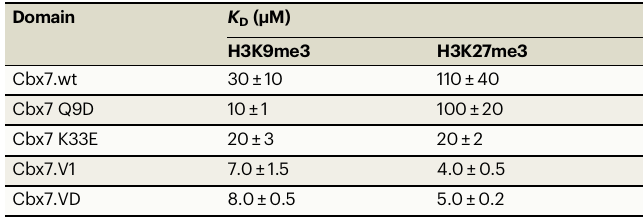
Table 2 | Dissociation constants for Cbx7.wt and variants for methylated histone